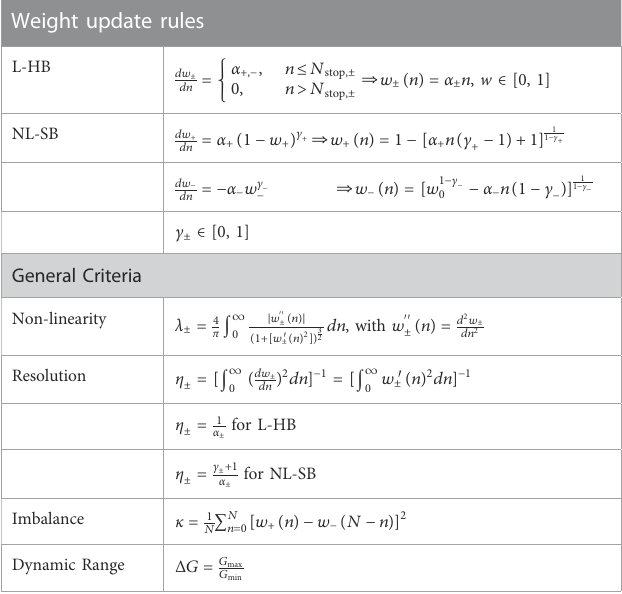
TABLE 1 Overview of the synapse criteria. Weight update